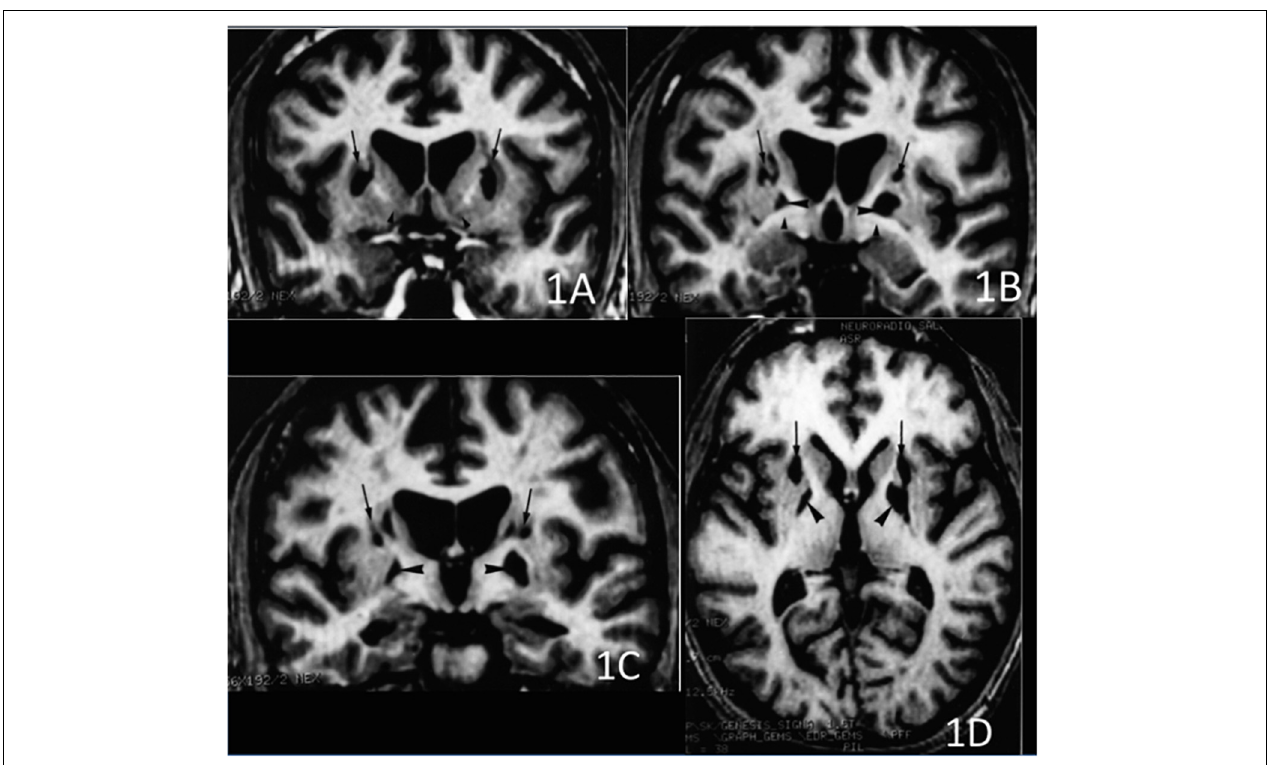
FIGURE 1 | 3D T1-weighted axial and coronal sections at 3 different rostro-caudal levels of the lesion of the basal ganglia. (A) Coronal section passing at the level of the head of the caudate nucleus and the ventral striatum. The lesions involved the dorsal striatum (arrows) while the ventral striatum was apparently spared (arrowheads). (B) Coronal section passing at the level of the anterior commissure. Infarction was located in the upper part of the putamen (arrows) and the globus pallidus (large arrowheads). The head of the caudate nucleus was atrophic. The ventral pallidum was spared (small arrowheads). (C) Coronal section passing at the level of the mammillary bodies. The lesion involved the upper part of both putamen (arrows) and the globus pallidus (arrowheads), bilaterally. (D) Axial section showing the rostro-caudal gradient of striatal lesion, which predominated in the rostral “associative” part of the striatum (arrows), and the lesion of the globus pallidus